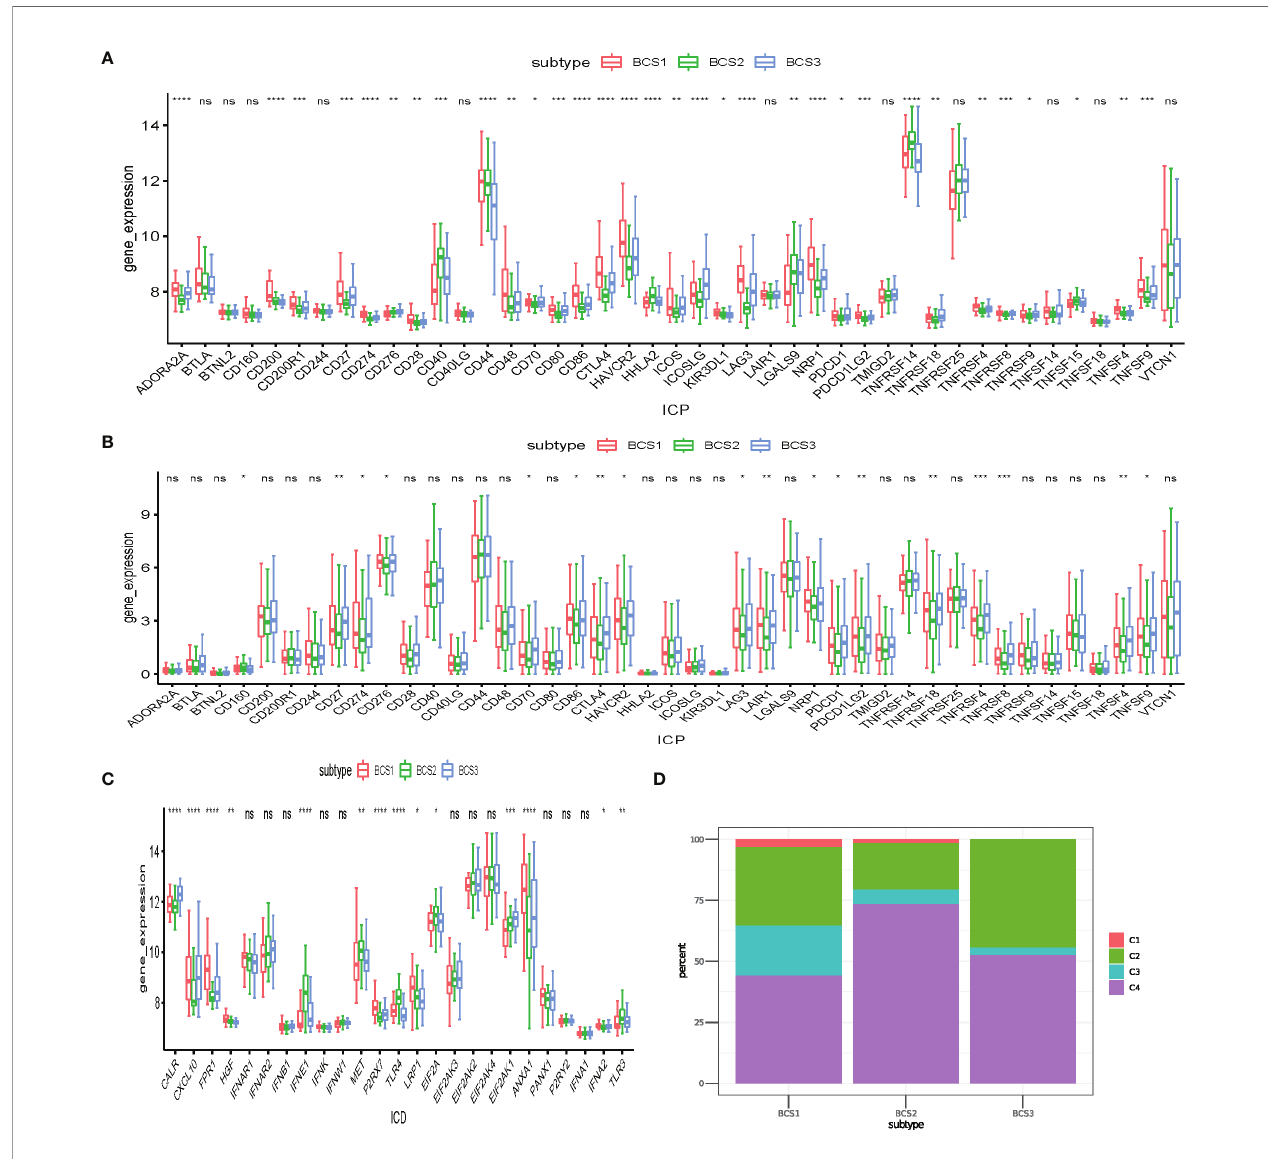
FIGURE 6 | Association between anti-tumor immunity between the three immune subtypes. (A, B) Differential expression of ICP genes among the BLCA immune subtypes in the (A) GEO and (B) TCGA cohorts. (C) Differential expression of ICD modulator genes among the BLCA immune subtypes in the GEO cohort. (D) Overlap of BLCA immune subtypes with 6 pan-cancer immune subtypes. * P < 0.05, ** P < 0.01, *** P <0.001, **** P <0.0001, and ‘ ns ’ represents not signi fi